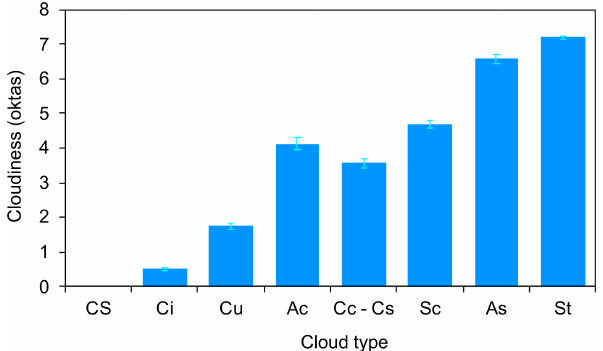
Figure 8. Cloudiness associated with each cloud